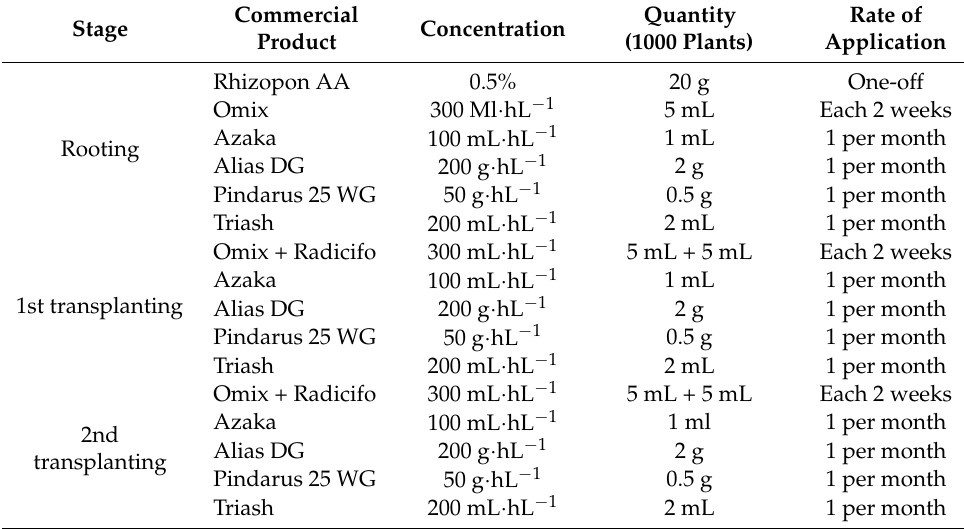
Table 3. Chemical treatments used at each stage of the two ornamental production models: conven- tional production model (CM) and novel and sustainable production model